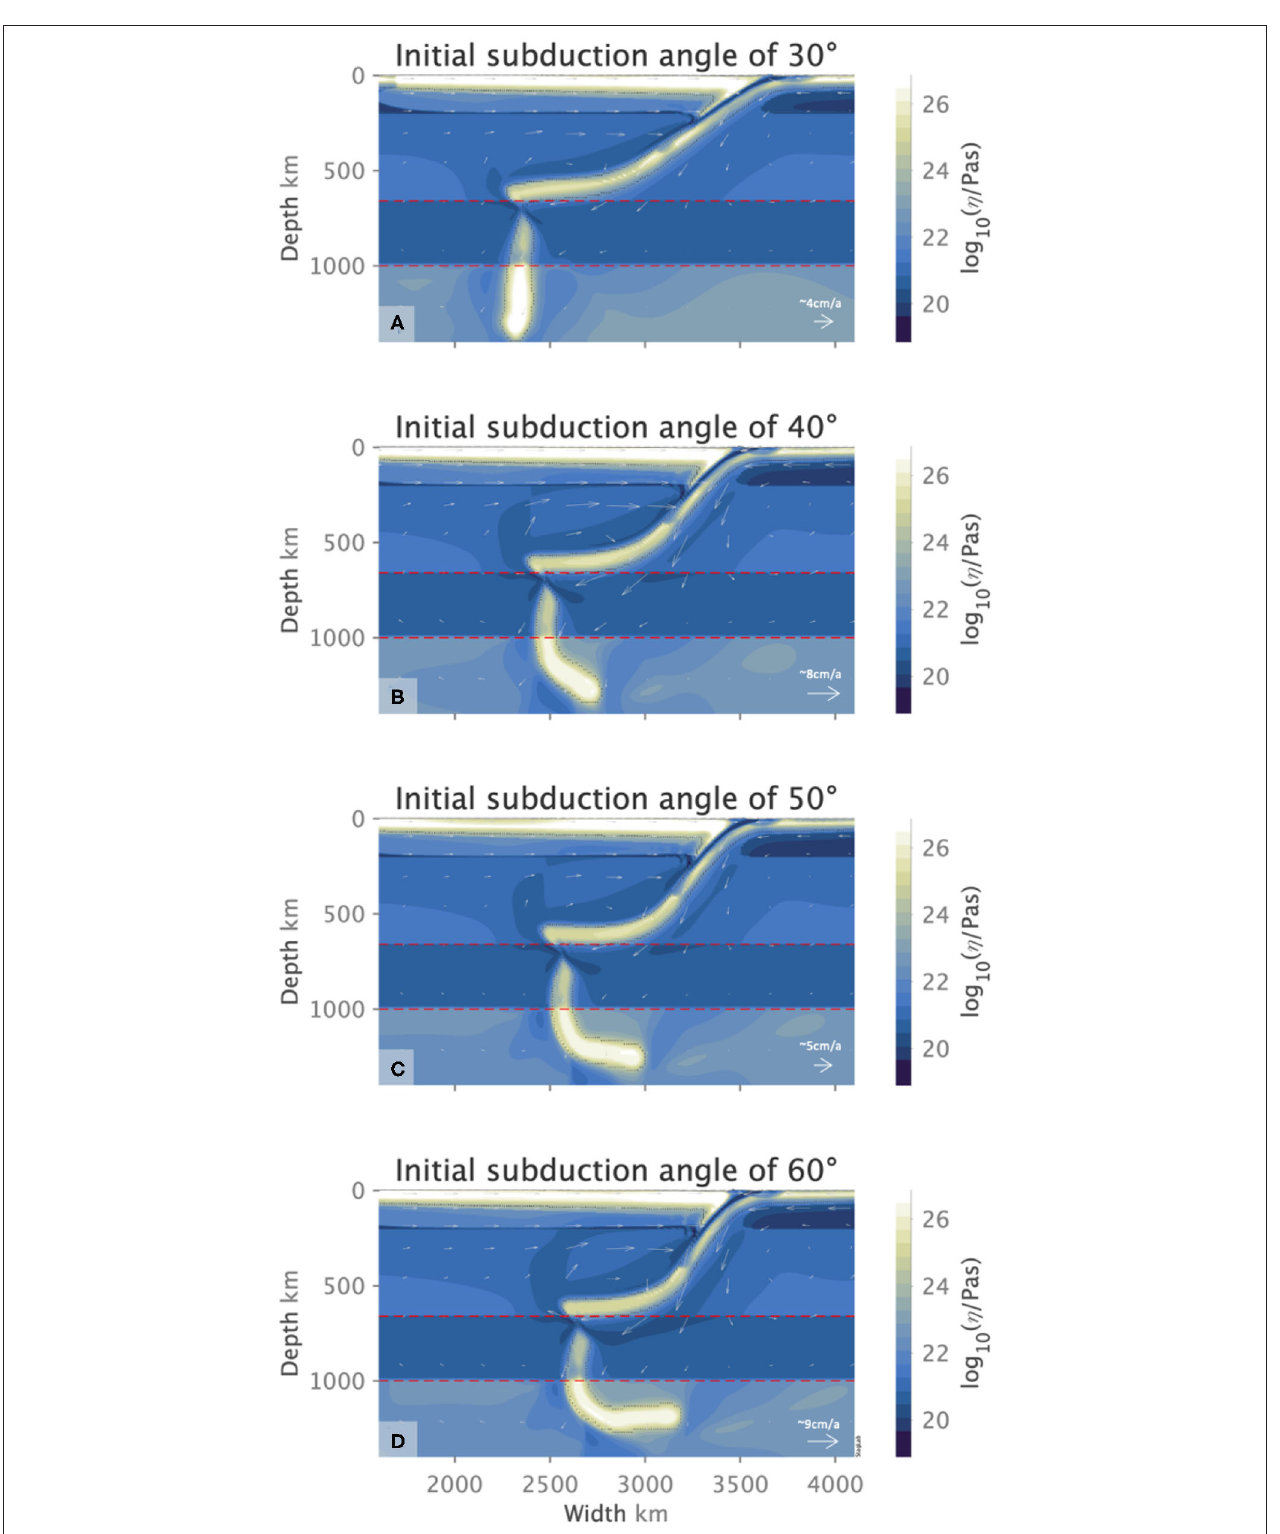
FIGURE 8 | Slab orphaning at 22.5 Myr (A) , 16.5 Myr (B) , 17 Myr (C) , and 18 Myr (D) for initial subduction angles of 30 ◦ , 40 ◦ , 50 ◦ , and 60 ◦ , respectively in the presence of a continental overriding plate, showing steep, curved, and overturned orphan slabs. The deep continental roots of the overriding plate reduces the overall subduction velocities due to increased coupling between the overriding plate and the uppermost-upper mantle. This encourages longer orphaning periods. Flow arrows indicate the sense of flow direction and its relative magnitude for each figure.